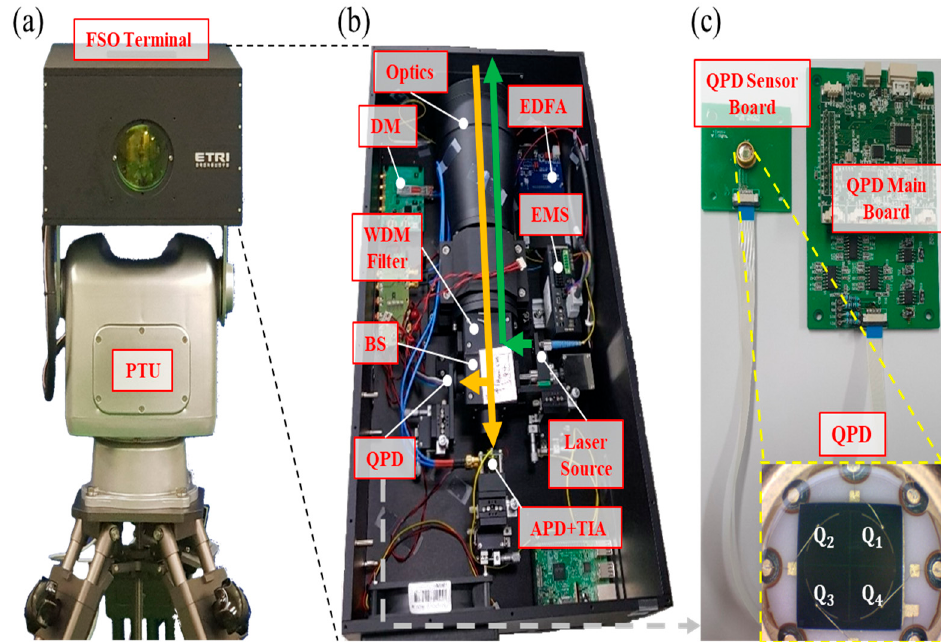
Figure 3. ( a ) FSO terminal on PTU, ( b ) inside view of FSO terminal, and ( c ) custom-designed quadrature photodiode (QPD) sensor board and main board for precision PAT.